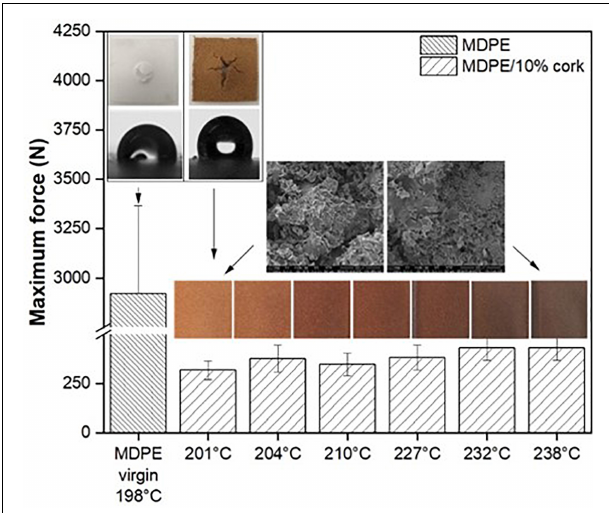
FIGURE 11 | Relationship between processing and properties of